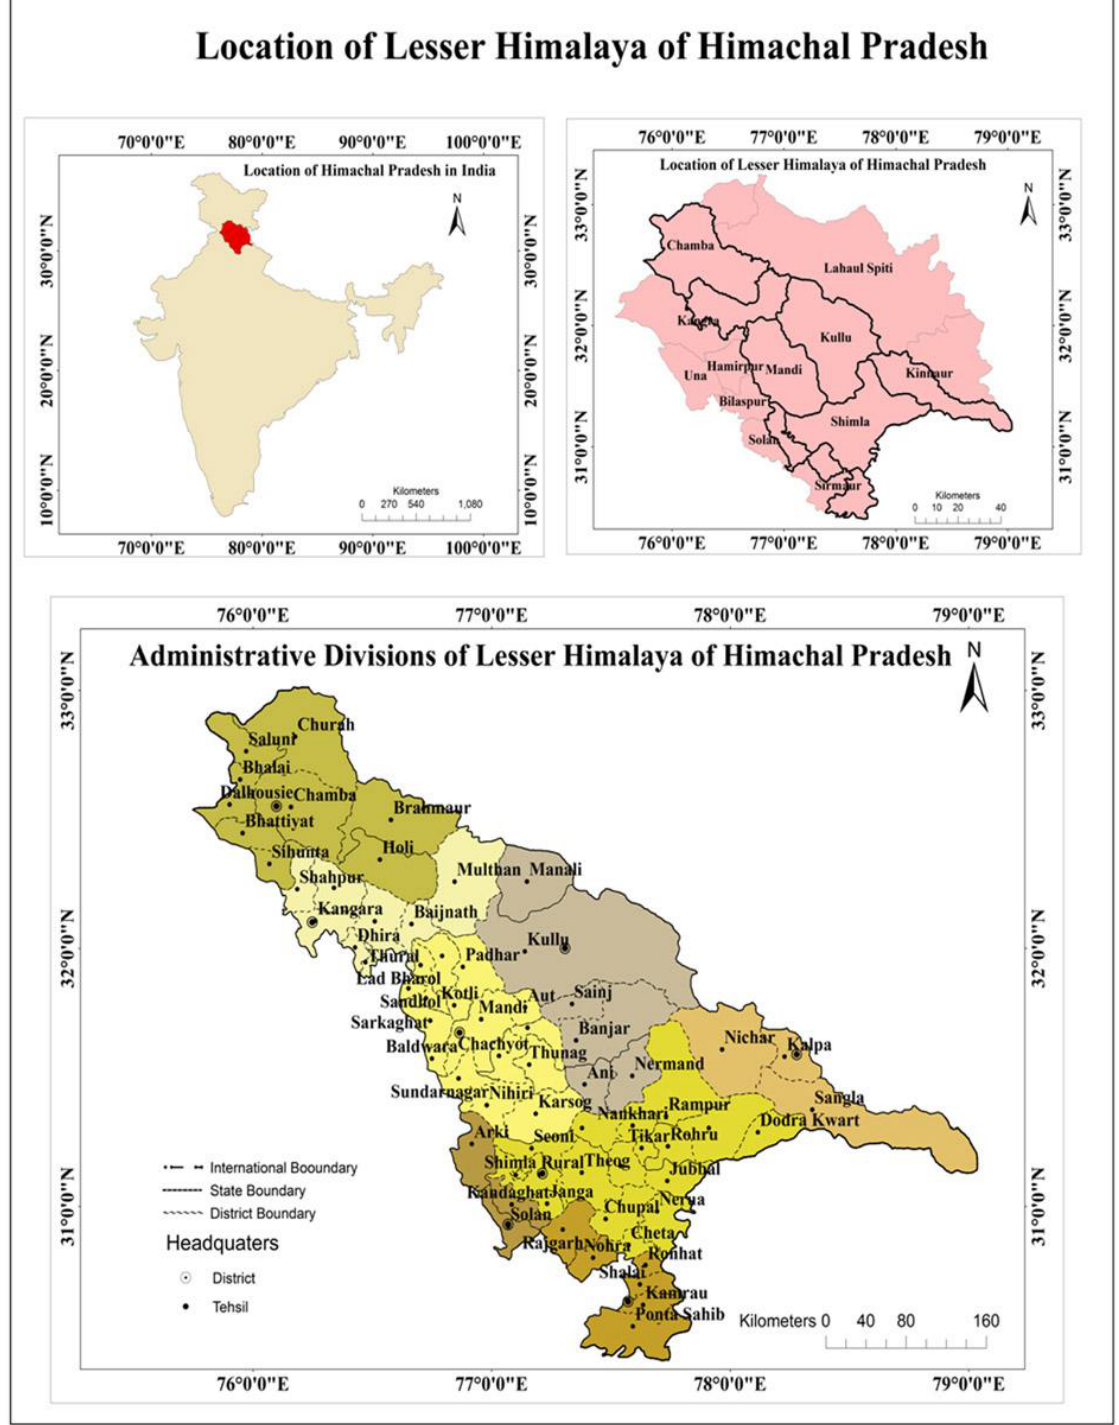
Fig. 1. Location of study area (after Singh, 1999; Sidhu et al.,